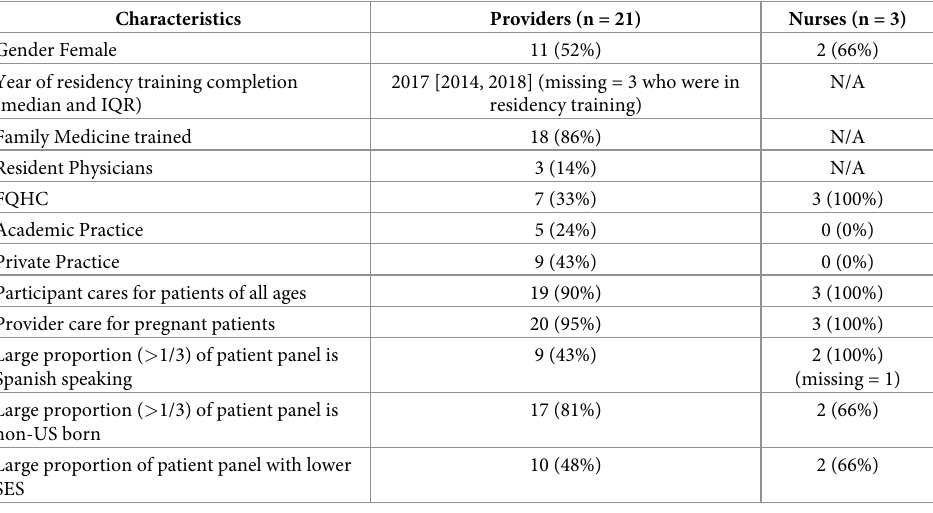
Table 1. Demographics of primary care providers and nurses interviewed (n =